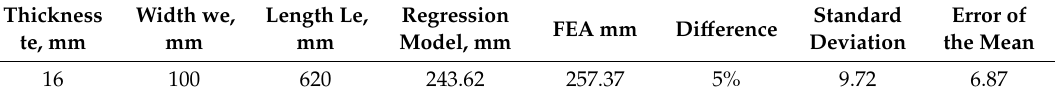
Table 5. Comparison of deflections for optimum dimensions from regression and FEA results.